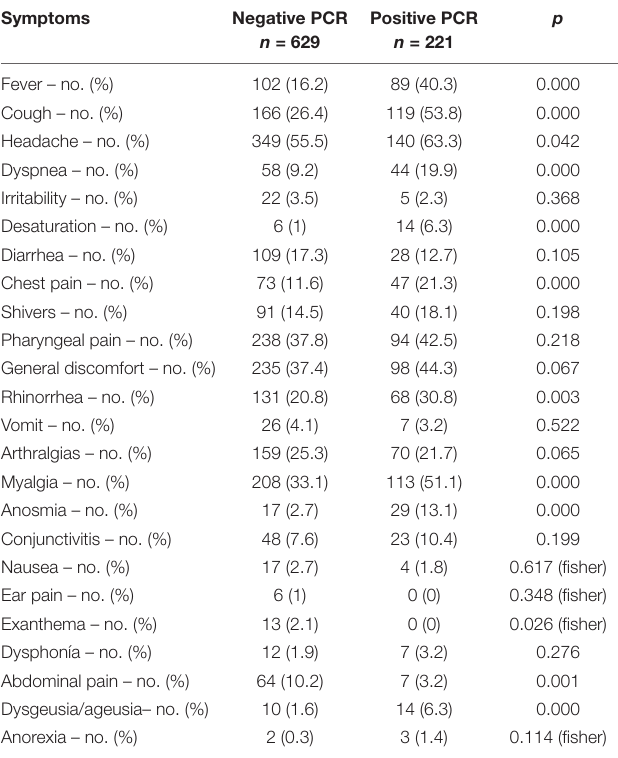
TABLE 3 | Symptoms in positive and negative